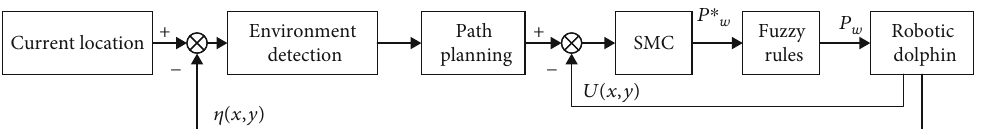
Figure 11: Block diagram of path tracking based on machine